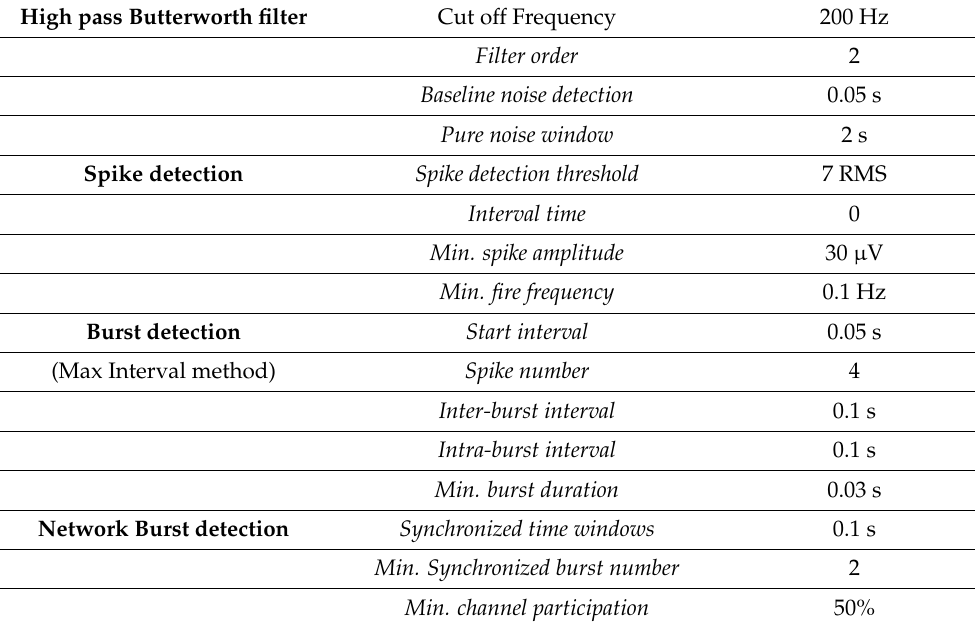
Table 1. Parameters for the post processing calculation of the selected endpoints. High pass Butterworth